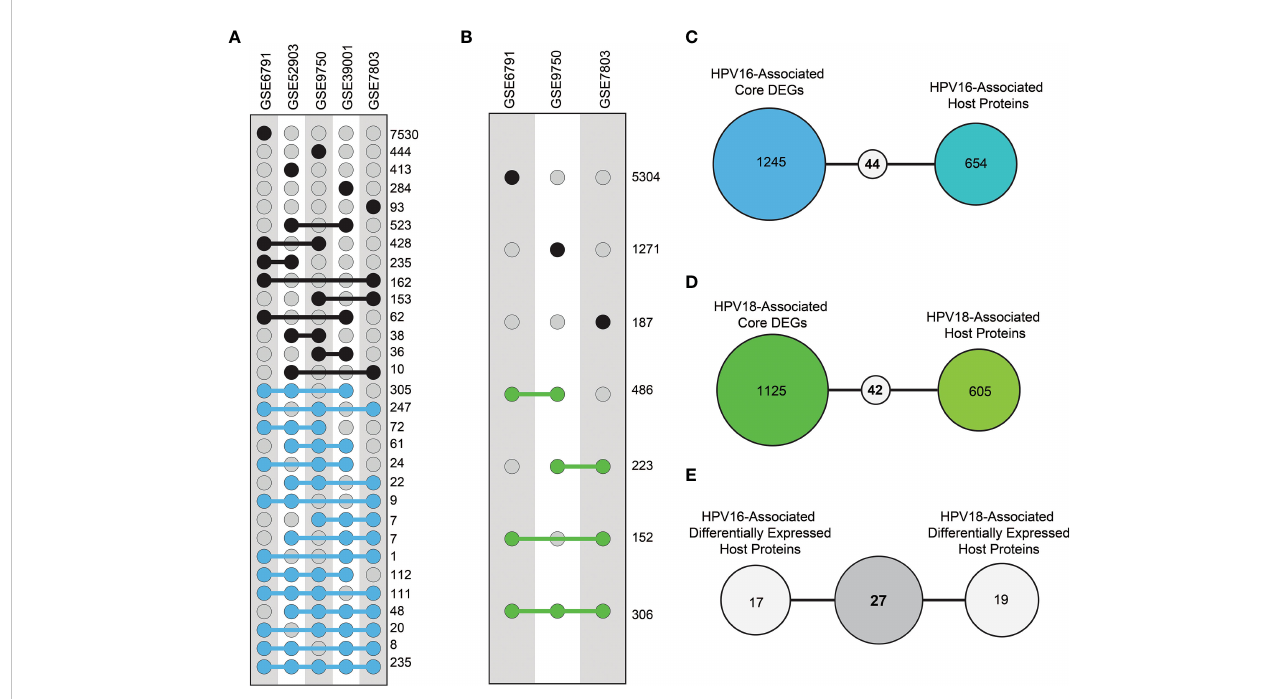
FIGURE 3 The distribution of differentially expressed genes (DEGs) and differentially expressed host proteins (DE-HPs). (A) The graph represents DEGs in transcriptome datasets with HPV16 samples from cervical cancer. The blue dots represent DEGs that share at least three of the fi ve HPV16 datasets (i.e., core DEGs of HPV16). (B) The graph represents DEGs in the transcriptome datasets that involve HPV18 cervical cancer samples. The green dots represent DEGs present in at least two of the three HPV18 datasets (i.e., core DEGs of HPV18). (C) The diagram shows the number of common elements between HPV16-associated core DEGs and HPV16-associated host proteins. (D) The diagram shows the number of common elements between HPV18- associated core DEGs and HPV18-associated host proteins (E) The diagram shows the number of common host proteins between HPV16-associated DE-HPs and HPV18-associated